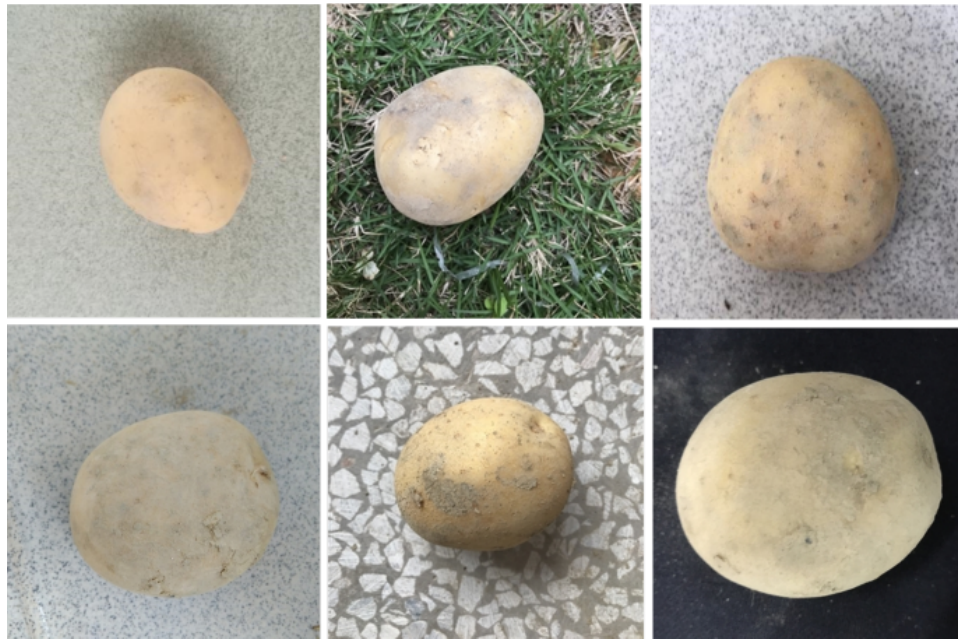
Figure 2. The potato images are taken at different locations of the campus of Huizhou University with different angles, creating a diverse dataset of